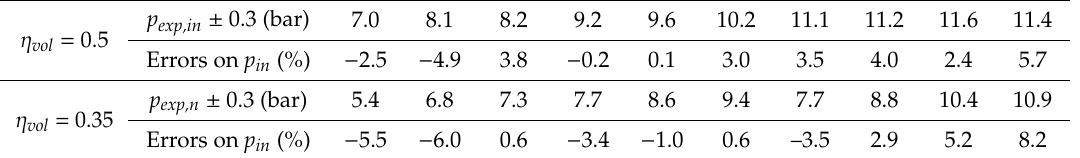
Table 2. Experimental validation of the numerical mode with η vol = 0.5 and η vol = 0.35.